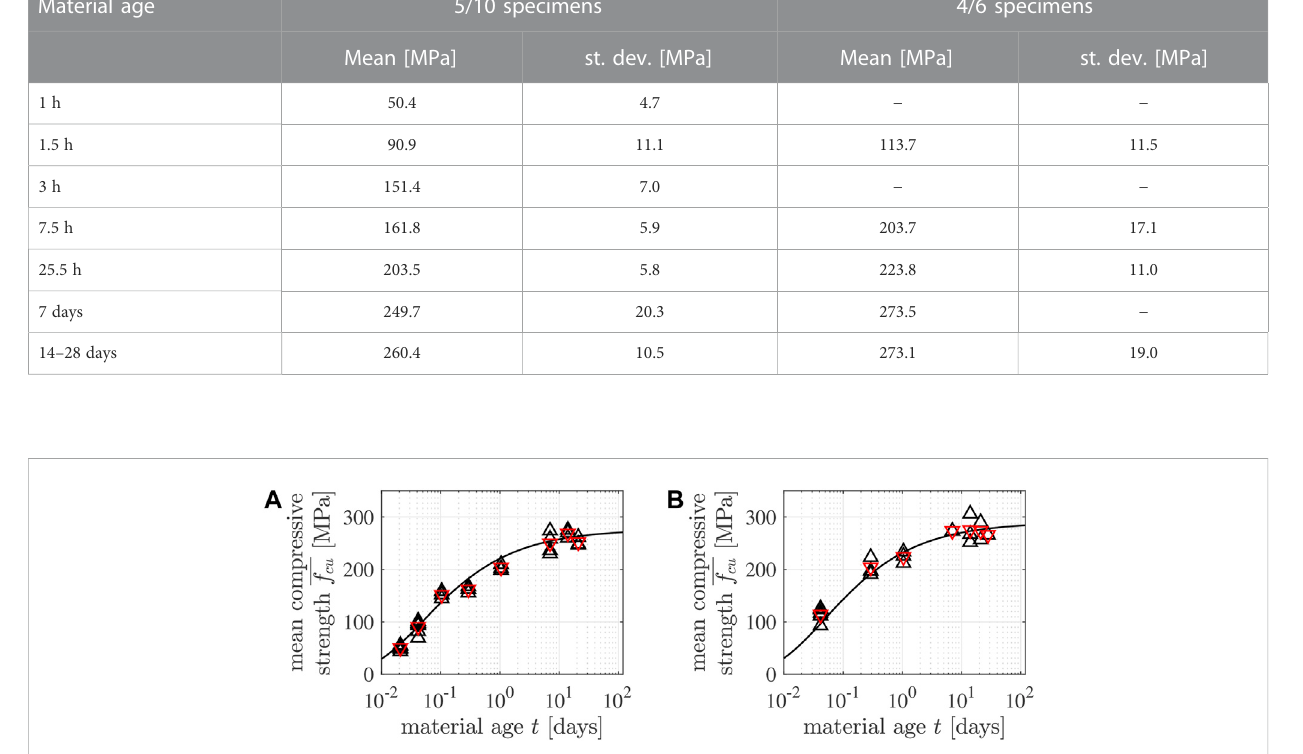
TABLE 6 Average compressive strength values as a function of specimen type and material age; the underlying individual strength values are listed in Tables 4, 5. Material age 5/10 specimens